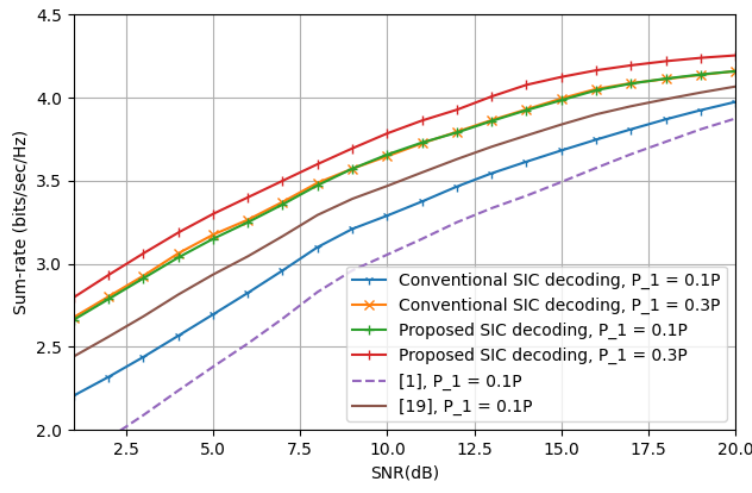
Figure 9. Sum rate versus SNR for the conventional and proposed SIC schemes with varying power allocations.